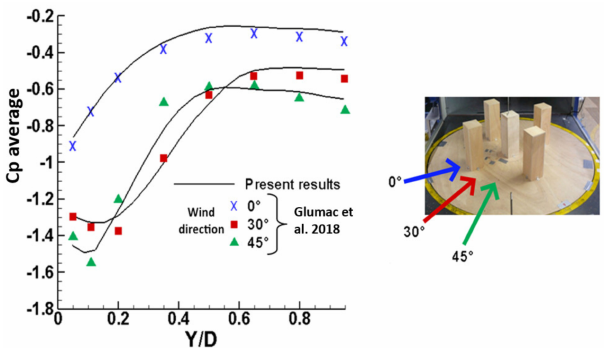
Figure 5. Comparison of the pressure coefficient profiles for different wind angles with Glumac et al.